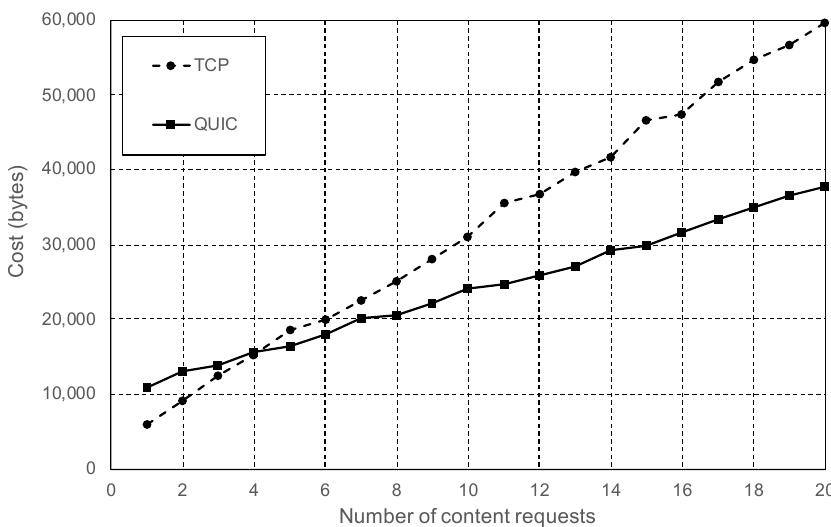
Figure 9. Total number of bytes required to fetch content from another node including the initial connection.